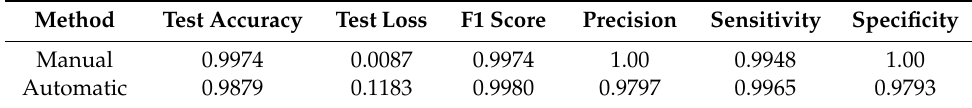
Table A2. Result on Cross-Validation